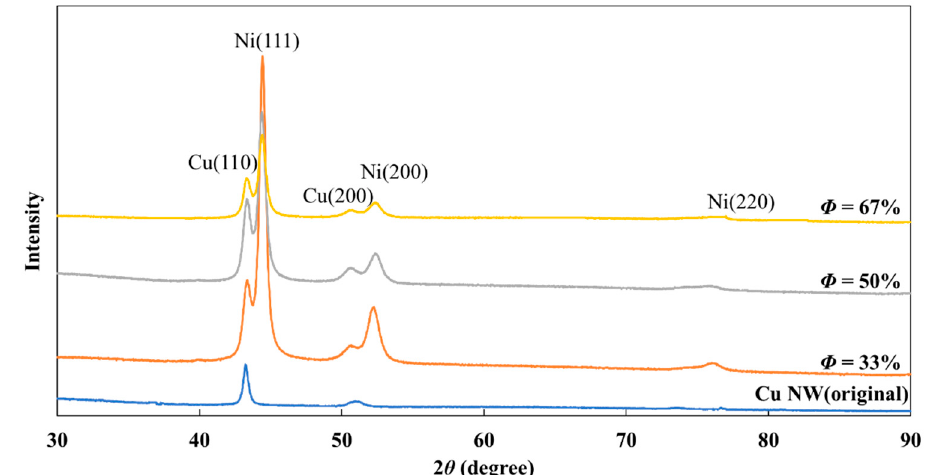
Figure 7. XRD patterns showing the influence of duty cycle ( φ ) on the crystal orientation of nickel deposits for an average applied voltage of 1.25 V.